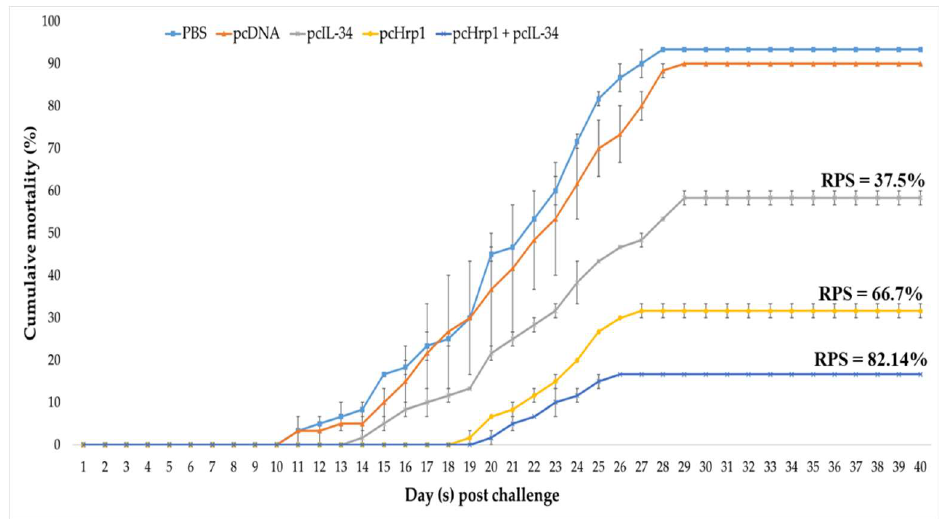
Figure 11. The cumulative mortality of largemouth bass challenged with N. seriolae . Each treatment group contained 30 fish. The fish were observed daily for 40 days to calculate the cumulative mortality, and the experiment was conducted in duplicate. Results are presented as means ± SD (n = 2). RPS = relative percent of mortality.